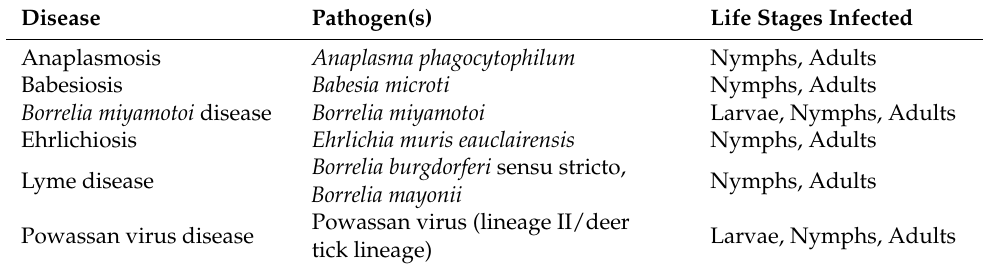
Table 1. Ixodes scapularis pathogens and human disease.